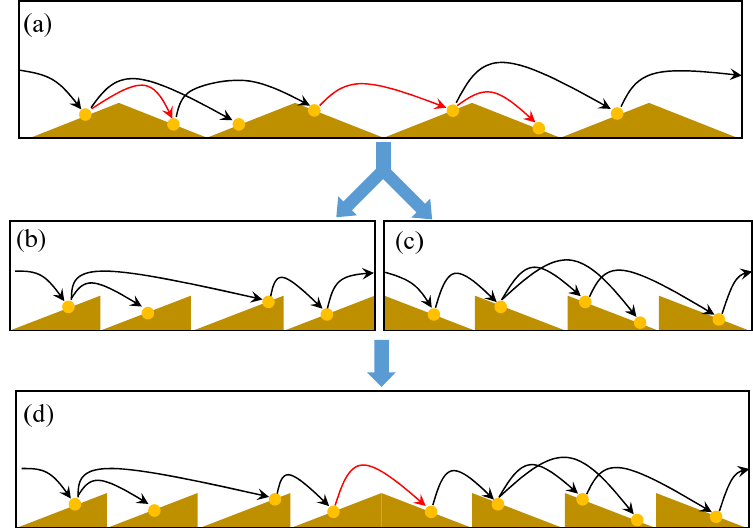
Figure 5. A sketch of our simplification procedure. Black lines represent monotone trajectories. Red lines represent non-monotone trajectories. ( a ) is the original system. ( b , c ) are systems that only contain the particles with monotone trajectories. ( a ) can be roughly approached by the combination of ( b , c ), which is shown in ( d ).